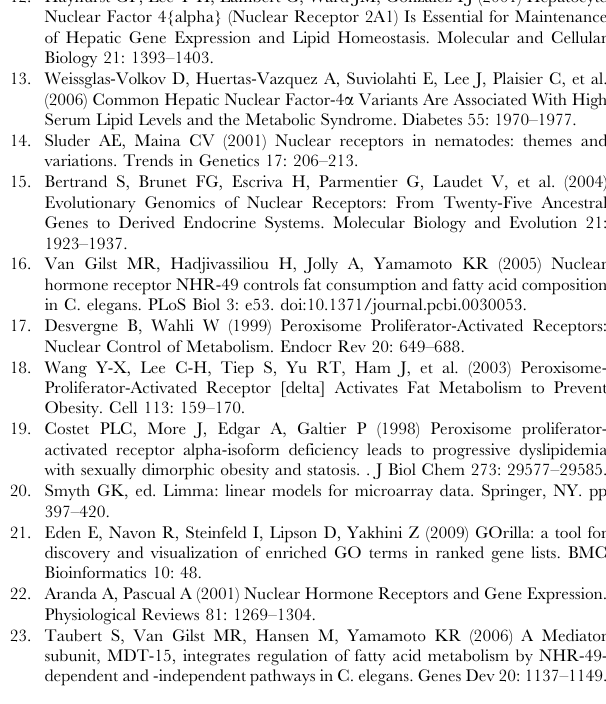
Table S8 Occurrence of gene families in microarray results for NHR-80, based on GO terms. Table S9 List of common genes regulated by NHR-49 and NHR-66 and list of common genes regulated by NHR-49 and common to NHR-49 and NHR-80. Table S10 Summary of lifespan data. Table S11 Lifespan and relative C18:0 fatty acid